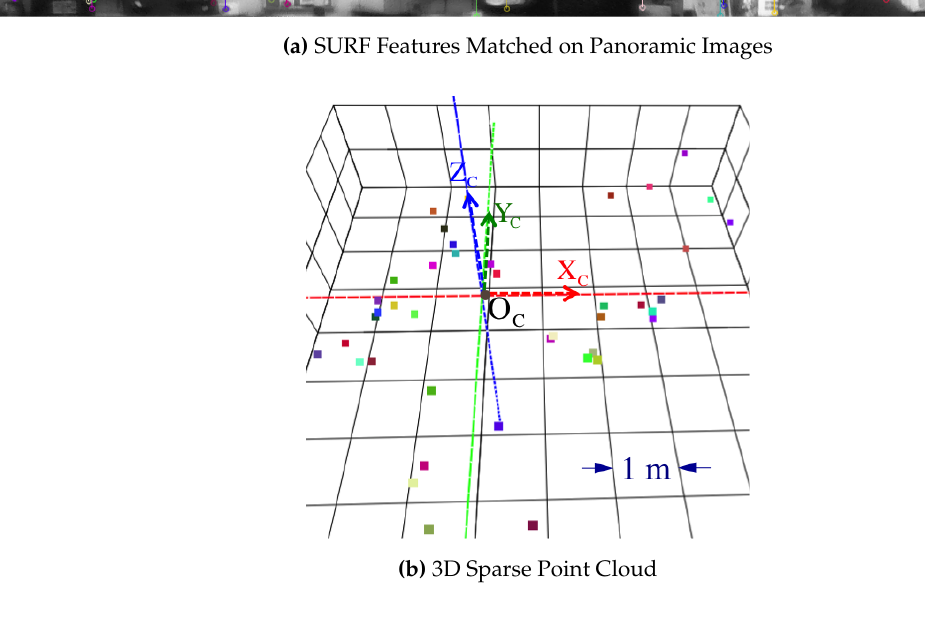
Figure 22. Sparse point correspondences for the real-life image from Figure 13b. Point correspondences are identifiable by random colors that persist in both the panoramic image and the respective triangulated 3D points (scaled-up for